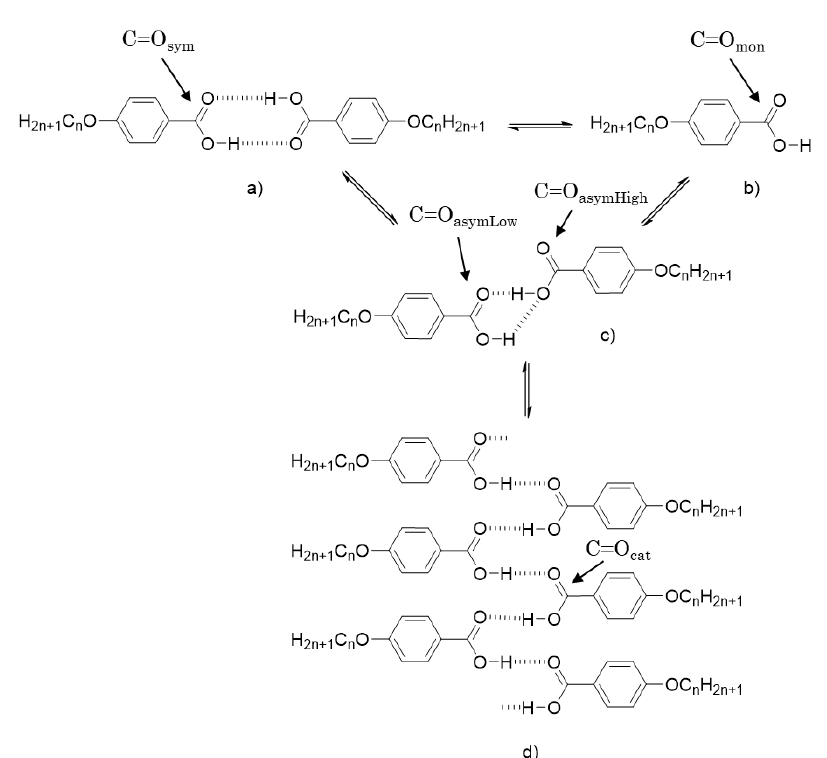
Figure 8. Temperature-dependent FT-IR spectra of the CB6OBA:4OS mixtures obtained on cooling from the isotropic melt: ( a ) High frequency and ( b ) carbonyl stretching region.